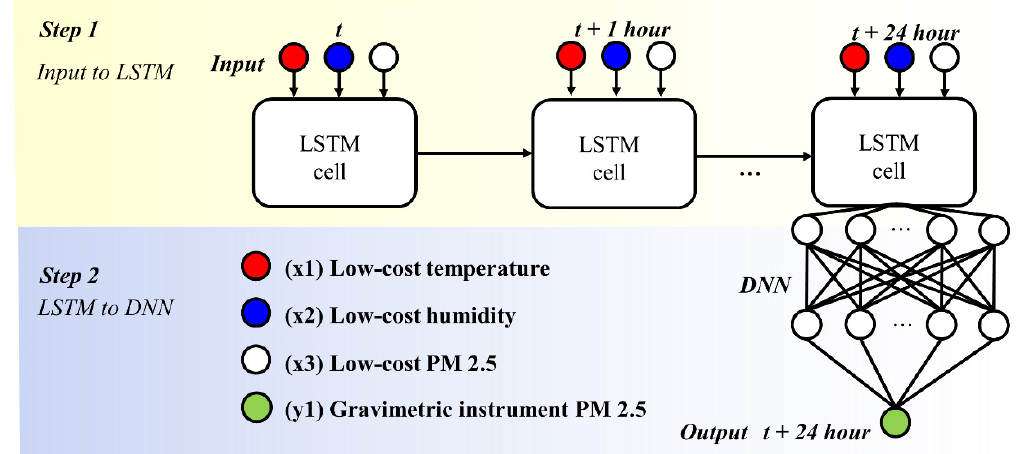
Figure 3. Example of HybridLSTM model architecture.